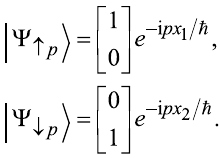
When considering processes that transfers electrons from the left to the right, we can, because of the helicity of the edge states, restrict ourselves to up-spins along the upper edge, and down-spins along the lower edge. Further, we introduce the co- ordinate x 1 = r (2 π − θ ) and x 2 = r θ along the upper and lower edges, respectively. The eigenvalue equations along the two edges are